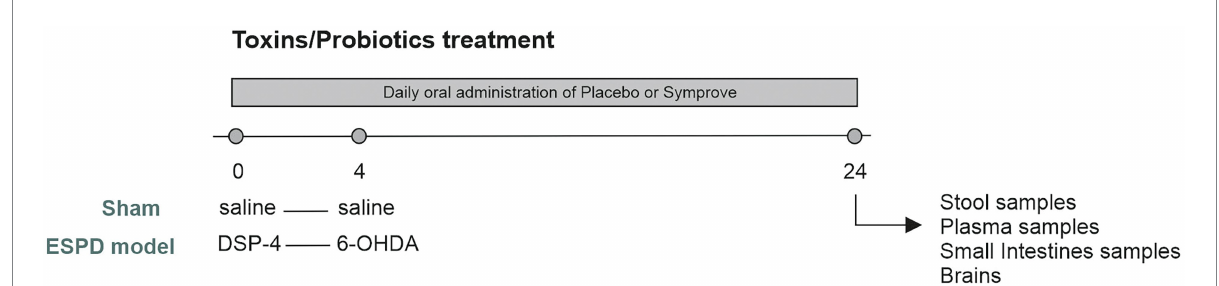
FIGURE 1 Experimental protocol. Adult male rats (200–250 g) were randomly allocated to four experimental groups. Animals received either saline (Sham) or DSP-4 [Early-stage Parkinson’s Disease (ESPD) model] at Day 0. Three days later, animals underwent stereotaxic surgeries in which they received either saline (sham) or 6-hydroxydopamine (6-OHDA) (ESPD model) and were maintained for 20 days after surgery. 0.5 mL of placebo or Symprove ™ were given orally, daily, from day 0 until the end of the experiment. Rats were culled at Day 24 and fecal, small intestine, plasma samples and brains were collected for